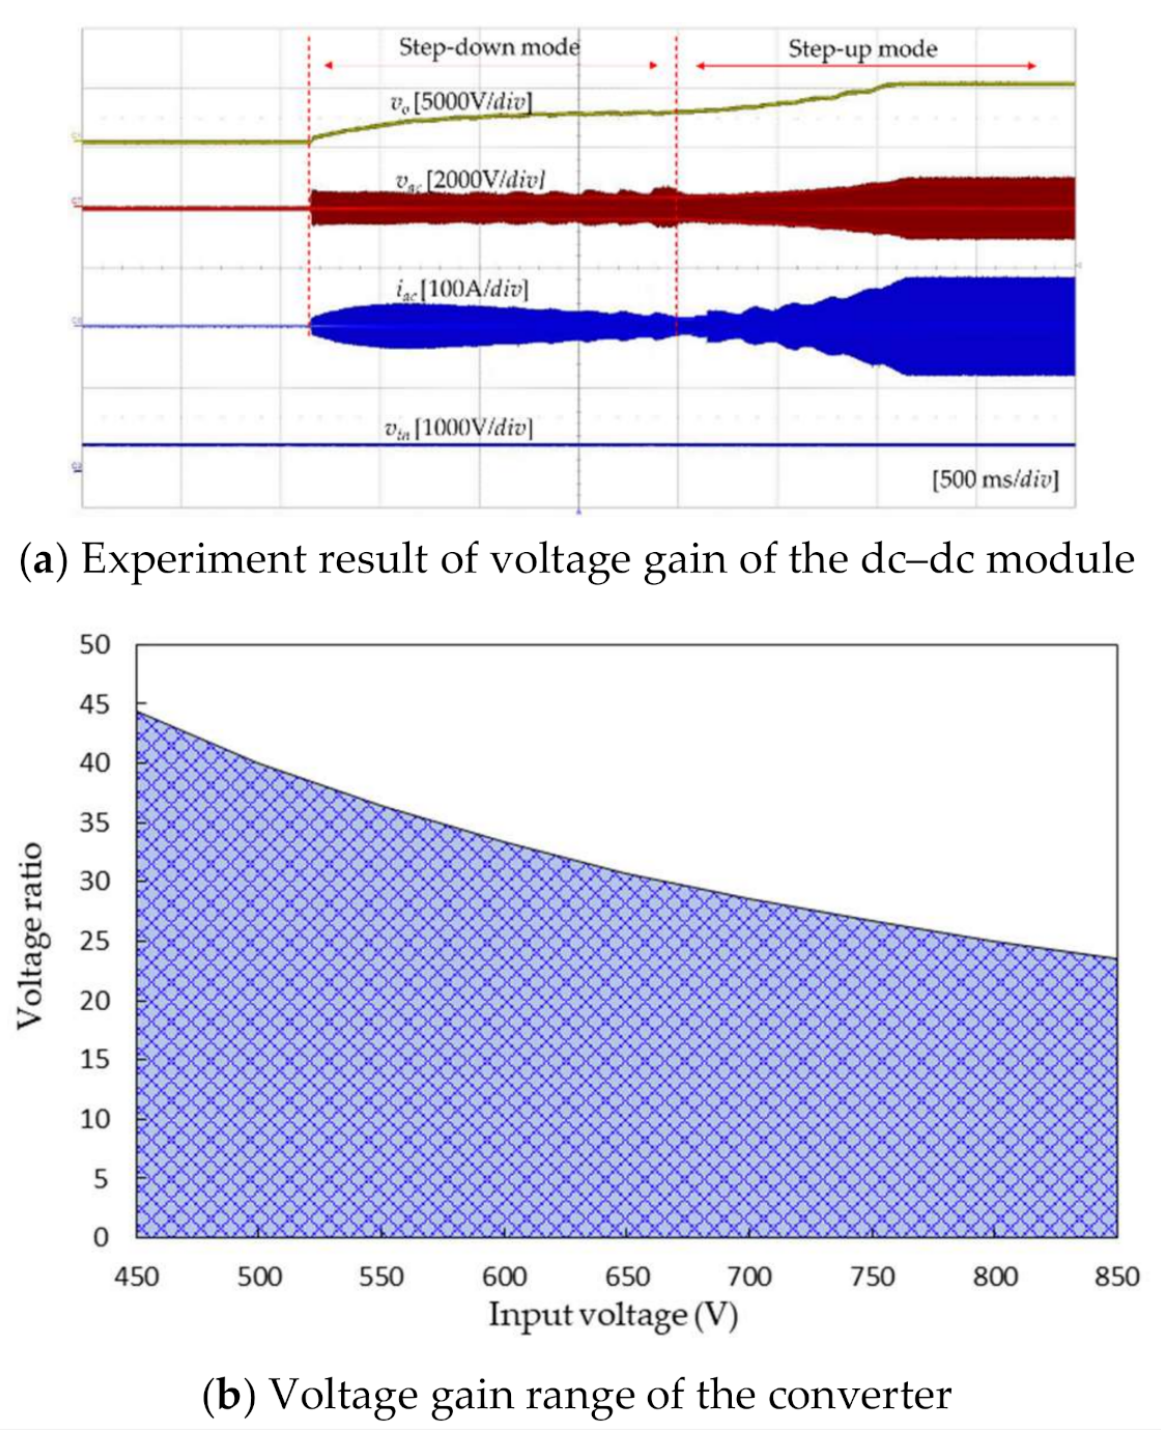
Figure 22. Voltage gain of the dc–dc module and